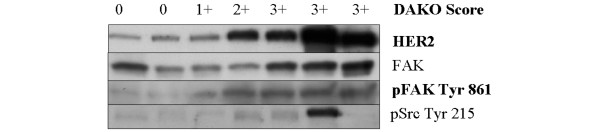
Upregulation of tyrosine phosphorylation of focal adhesion kinase (FAK) at tyrosine 861 in HER2-overexpressing breast tumors. Western blot analysis: lysates of seven breast cancer samples were analyzed by immunoblotting using antibodies that recognize total FAK and distinct tyrosine sites on Src and FAK kinases. Tumor samples were put in order according to the HER2 expression status (HerceptTest™) and the blot was probed with anti-HER2 antibody to analyze the exact amount of HER2 protein.